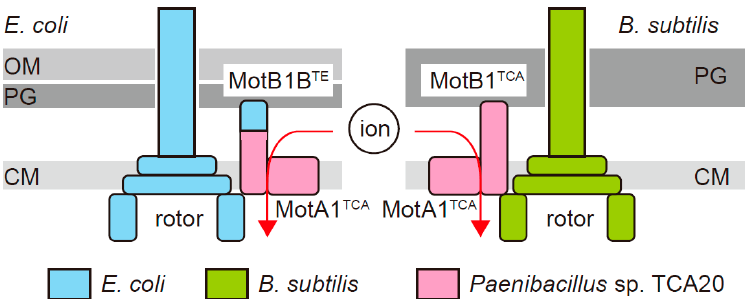
Figure 1. Schematic diagram of chimeric flagellar motors in Escherichia coli and Bacillus subtilis . In E. coli , the chimeric stator proteins, MotA1 TCA /MotB1B TE , interact with an E. coli rotor. In B. subtilis , MotA1 TCA /MotB1 TCA interacts with a B. subtilis rotor. The regions derived from E. coli, B. subtilis, and Paenibacillus sp. TCA20 are colored light blue, green, and magenta, respectively. OM: outer membrane, PG: peptidoglycan layer, CM: cytoplasmic membrane.